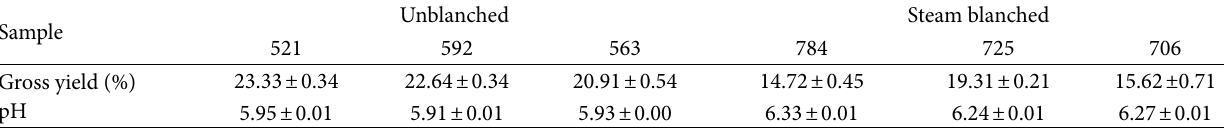
Table 2: Gross yield percentages & pH.